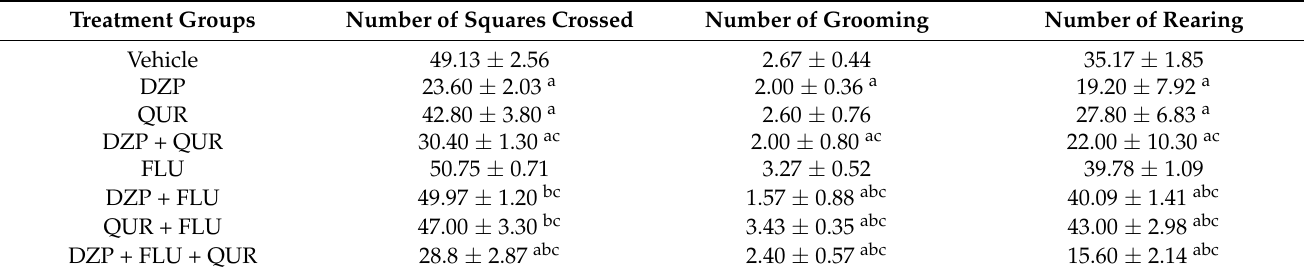
Table 1. Effects of test sample and controls in Swiss mice (open-field test). Treatment Groups Number of Squares Crossed